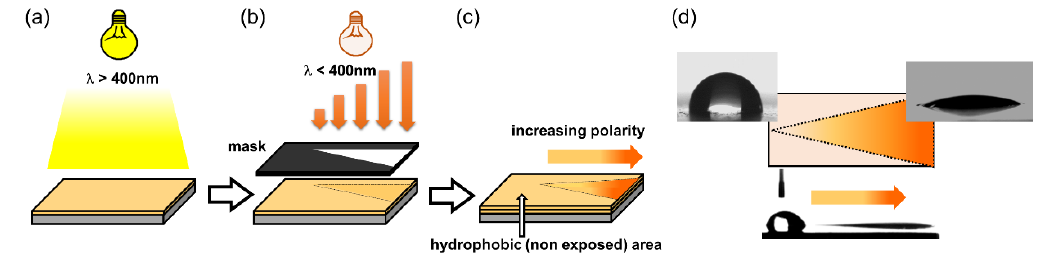
Figure 11. Schematic illustration of ( a ) photopolymerization of the thiol-yne network at long wavelength. ( b ) Patterned and asymmetrical UV exposure to realize ( c ) a wedge-shaped surface area with a lengthwise wettability gradient, which is surrounded by the hydrophobic (not exposed and thus, not-cleaved) thiol-yne network. ( d ) Water contact angle and droplet movement on the irradiated surface (Adapted from reference [89] published by the Royal Society of Chemistry).